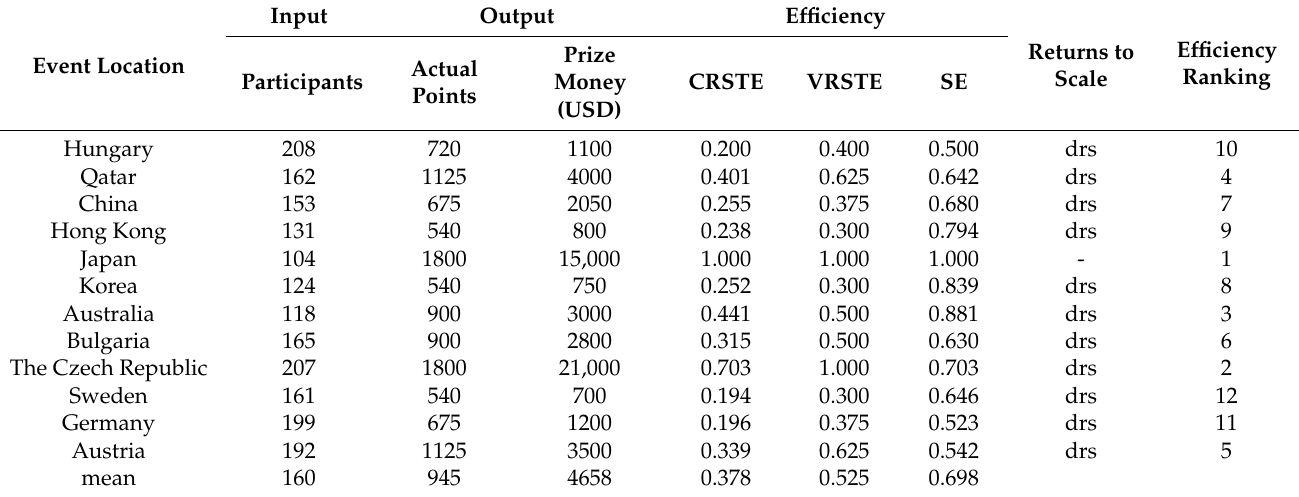
Table 6. Prize-winning efficiency for the 2019 ITTF World